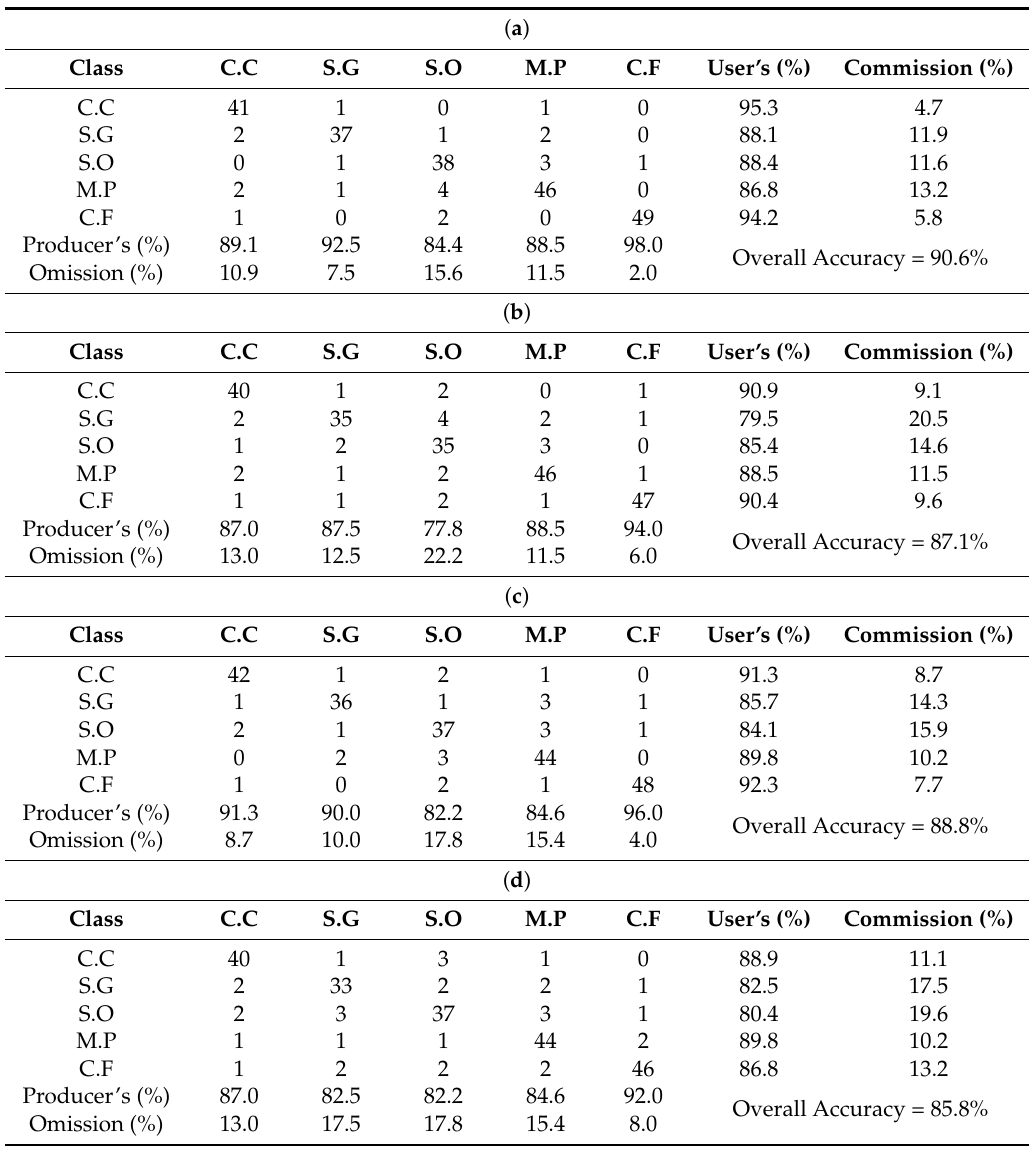
Table 7. Confusion matrix (including overall accuracies, per-class user’s and producer’s accuracies) for five tree-species classification using the validation dataset: ( a ) classification using the six most important metrics (LiDAR and sunlit hyperspectral metrics); ( b ) classification using the six most important metrics (LiDAR and crown hyperspectral metrics); ( c ) classification using the six most important metrics (Sunlit hyperspectral metrics); and ( d ) classification using the six most important metrics (Crown hyperspectral metrics). C.C = Chinese chestnut, S.G = Sweet gum, S.O = Sawtooth oak, M.P = Masson pine and C.F = Chinese